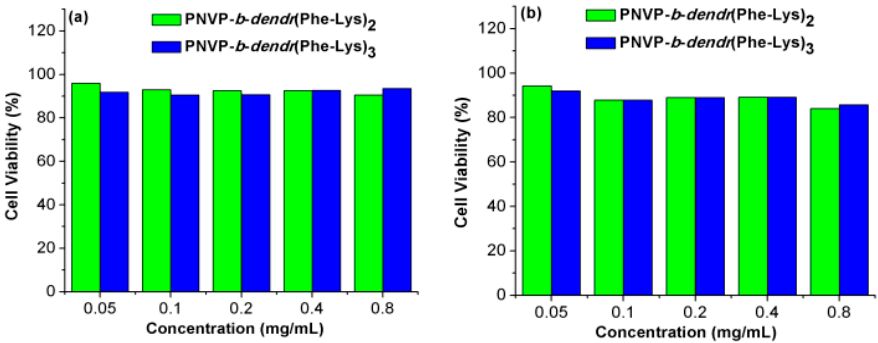
Figure 9. Cell viability of BEAS-2B ( a ) and SMMC-7721 ( b ) cells versus PNVP -b-dendr (Phe-Lys) 2 and PNVP -b-dendr (Phe-Lys) 3 .